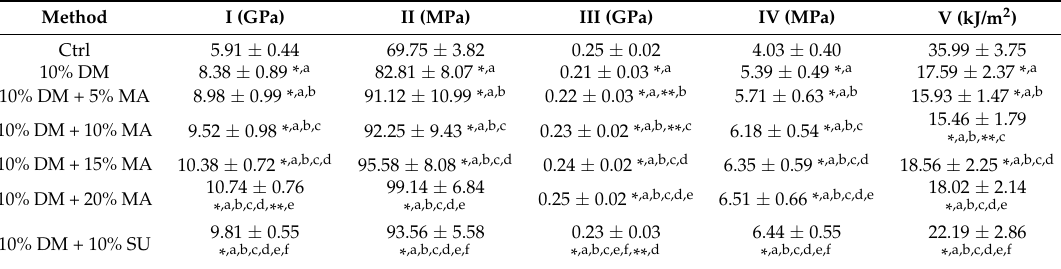
Figure 5. ( a ) Flexure modulus and ( b ) flexural strength of the samples treated with 10% DM, 10% DM + MA at different concentrations, and 10% DM + 10% SU. Compressive modulus ( c ) and compressive strength ( d ) of the samples treated with 10% DM, 10% DM + MA at different concentrations, and 10% DM + 10% SU. Table 4. Changes in the flexural and compressive of wood treated with different